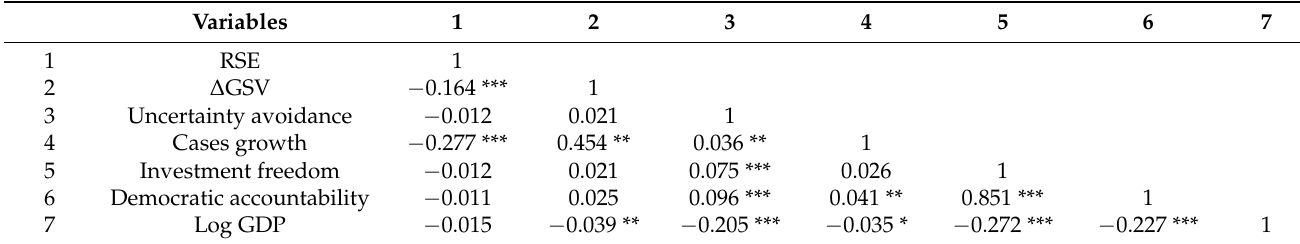
Table 2. Pairwise correlation analysis.